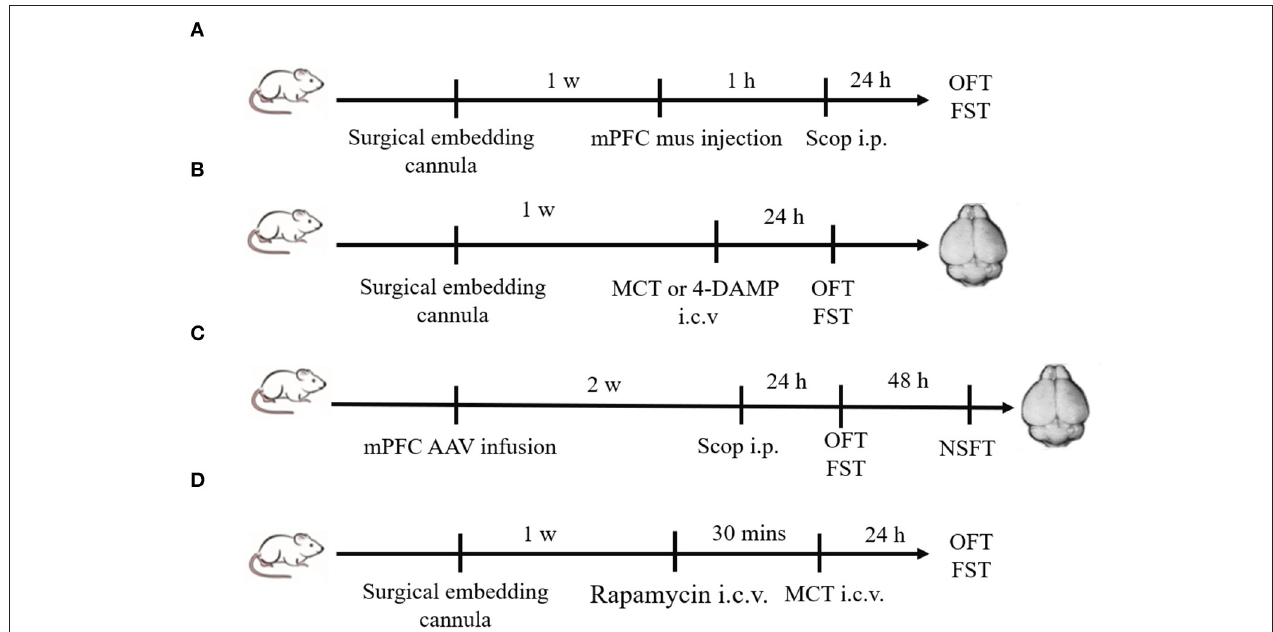
FIGURE 1 | Schematic diagram of experimental procedures. (A) Plastic guide cannulas were pre-implanted bilaterally into the mPFC. One week after recovery, muscimol (1.25 µ g / 2 µ l) was bilaterally injected through the cannulas 1h prior to scopolamine administration (i.p.), and behavior tests were conducted 24h after scopolamine administration. (B) Drugs (MCT or 4-DAMP) were bilaterally injected into the lateral ventricle through pre-implanted cannulas, and behavior tests were conducted 24h later. Then animals were sacrificed, and brains were rapidly removed. (C) Two weeks after mPFC AAV infusion, scopolamine was injected (i.p.). Twenty-four hours later, OFT and FST were sequentially conducted. After another 48h, NSFT were conducted. Then animals were sacrificed, and brains were rapidly removed. (D) Rapamycin (0.2 nmol/2 µ l) were bilaterally injected into the lateral ventricle through pre-implanted cannulas 30min prior to MCT administration (i.c.v.). OFT and FST were sequentially conducted 24h after MCT